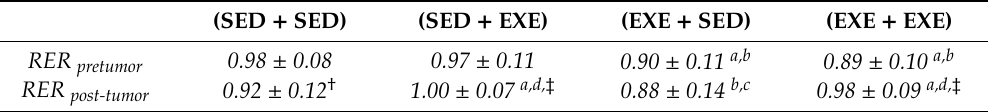
Table 2. Evaluation of the respiratory exchange ratio (RER) by indirect calorimetry (24 h). (SED + SED) (SED + EXE) RER pretumor RER pretumor: Preinoculation respiratory exchange ratio of tumor cells; RER post-tumor: Respiratory exchange ratio after 4 weeks of tumor inoculation, 36 h before sacrifice; SED + SED n = 9; SED + EXE n = 8; EXE + SED n = 6; EXE + EXE n = 8; one-way ANOVA with Bonferroni post hoc test ( a : **** p < 0.0001 vs. SED + SED; b : **** p < 0.0001 vs. SED + EXE; c : * p < 0.05 vs. SED + SED; d : **** p < 0.0001 vs. EXE + SED). Paired t -test (pretumor vs.